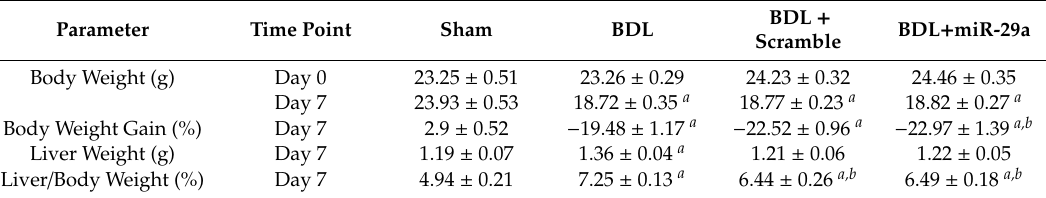
Table 1. Anthropometric measurements of the animals.